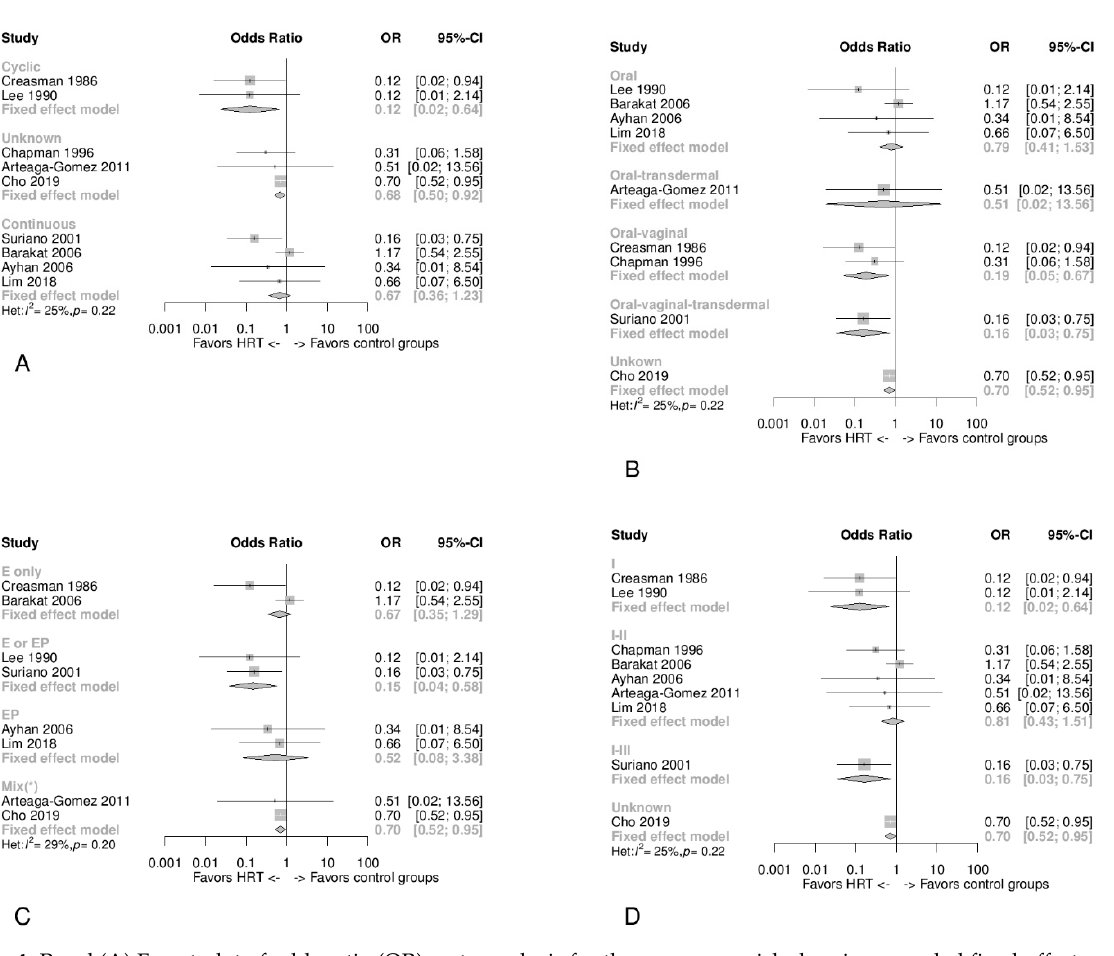
Figure 4. Panel ( A ) Forest plot of odds ratio (OR) meta-analysis for the recurrence risk showing a pooled fixed-effect model subgroup analysis by the timing of HT administration (cyclic vs. continuous). Panel ( B ) Forest plot of odds ratio (OR) meta-analysis for recurrence risk showing a pooled fixed-effect model subgroup analysis by method of HT administration. Panel ( C ) Forest plot of odds ratio (OR) meta-analysis for recurrence risk showing a pooled fixed-effect model subgroup analysis by type of HT (Chapman and coworkers was excluded due to an overlap with Suriano and coworkers; in addition, the mixed subgroup includes patients treated with tibolone). Panel ( D ) Forest plot of odds ratio (OR) meta-analysis for recurrence risk showing a pooled fixed-effect model subgroup analysis by tumor stage.